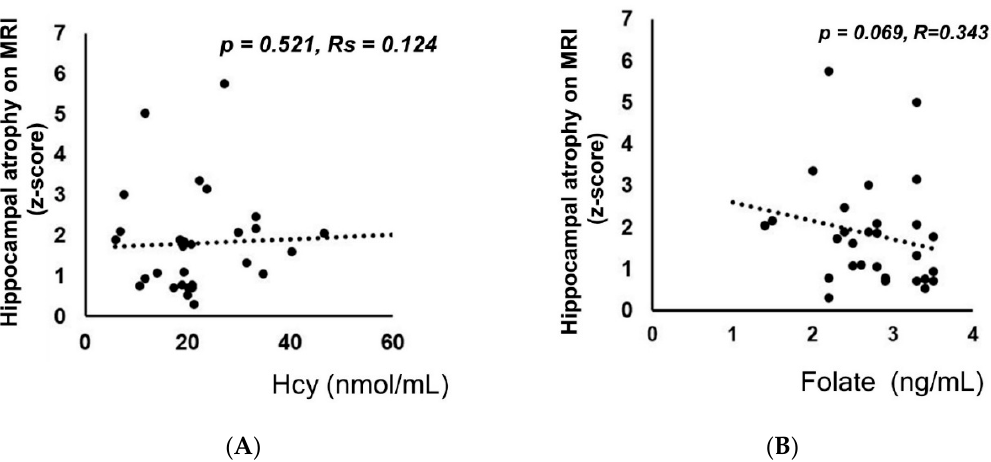
Figure 3. Plasma homocysteine (Hcy) levels or folate levels and the degree of hippocampal atrophy were not significantly correlated. There were no significant correlations between baseline Hcy levels and baseline hippocampal atrophy as estimated by the z-score produced by the voxel-based specific regional analysis system developed for the study of Alzheimer’s disease (VSRAD) ( p = 0.521, Rs = 0.124). ( A ) The folate concentration and hippocampal atrophy based on the VSRAD z-score were not significantly correlated ( p = 0.069, R = 0.343). ( B ) Spearman’s rank correlation coefficient was used for analysis because the data deviated from a normal distribution.